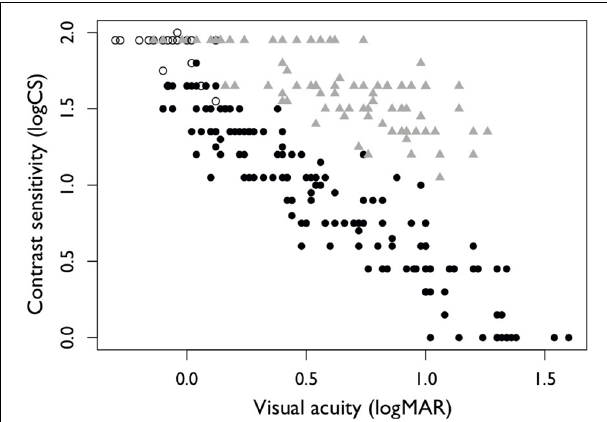
FIGURE 1 | Relationship between visual acuity (VA) and contrast sensitivity (CS) as measured under habitual condition (open circles), with simulated vision impairment by use of sim-specs (filled circles) and by use of refractive blur (gray filled triangles). Mean habitual VA was –0.06 logMAR units, and mean habitual CS was 1.88 logCS units.